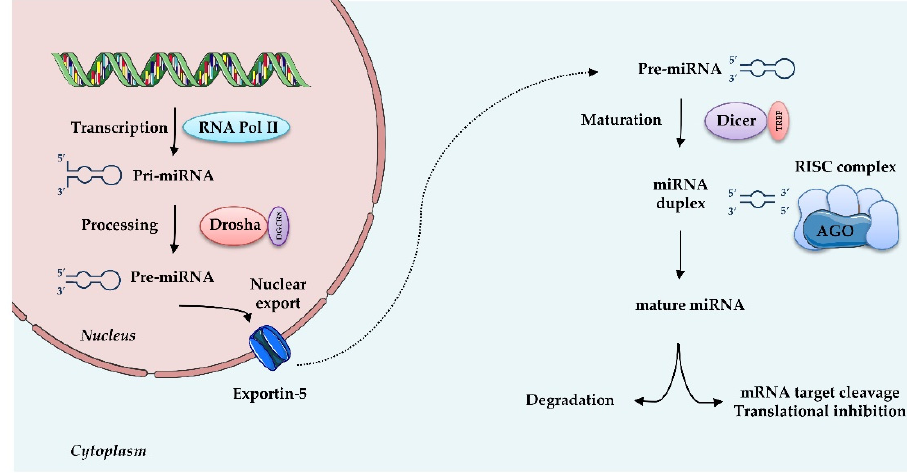
Figure 2. MicroRNAs biogenesis: microRNAs are transcribed by RNA Polymerase II (RNA Pol II) as large RNA precursors named pri-miRNA. Pri-miRNA is processed by the enzyme Drosha in association with the RNA-binding protein DGCR8 (DiGeorge syndrome critical region gene 8), which excises the stem-loop to form pre-miRNA. Pre-miRNAs are exported from the nucleus by a carrier protein known as Exportin-5. In the cytoplasm, pre-miRNA undergoes further processing by the Dicer-TRBP complex into a miRNA duplex approximately 20 nt long, known as 3’ and 5’ end strands. Typically, the first strand is degraded and the second is selected as mature miRNA. Mature miRNA is loaded into RNA induced silencing complex (RISC) via the AGO proteins and is then able to regulate gene expression by translational repression or induction of mRNA degradation. Increasing evidence suggests that, depending on the cell type or tissue, both strands can generate functional mature miRNAs.